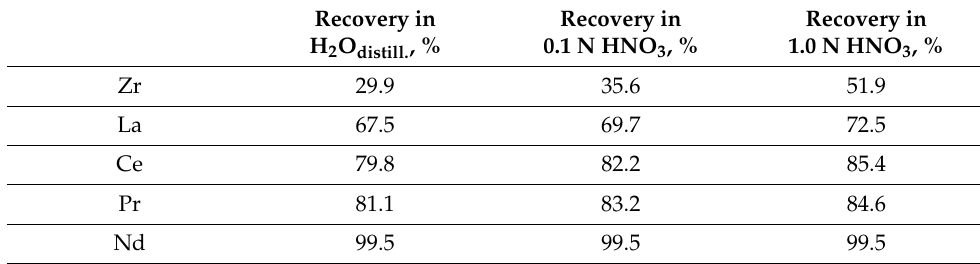
Table 12. REE and Zr recovery with elution with various eluents.